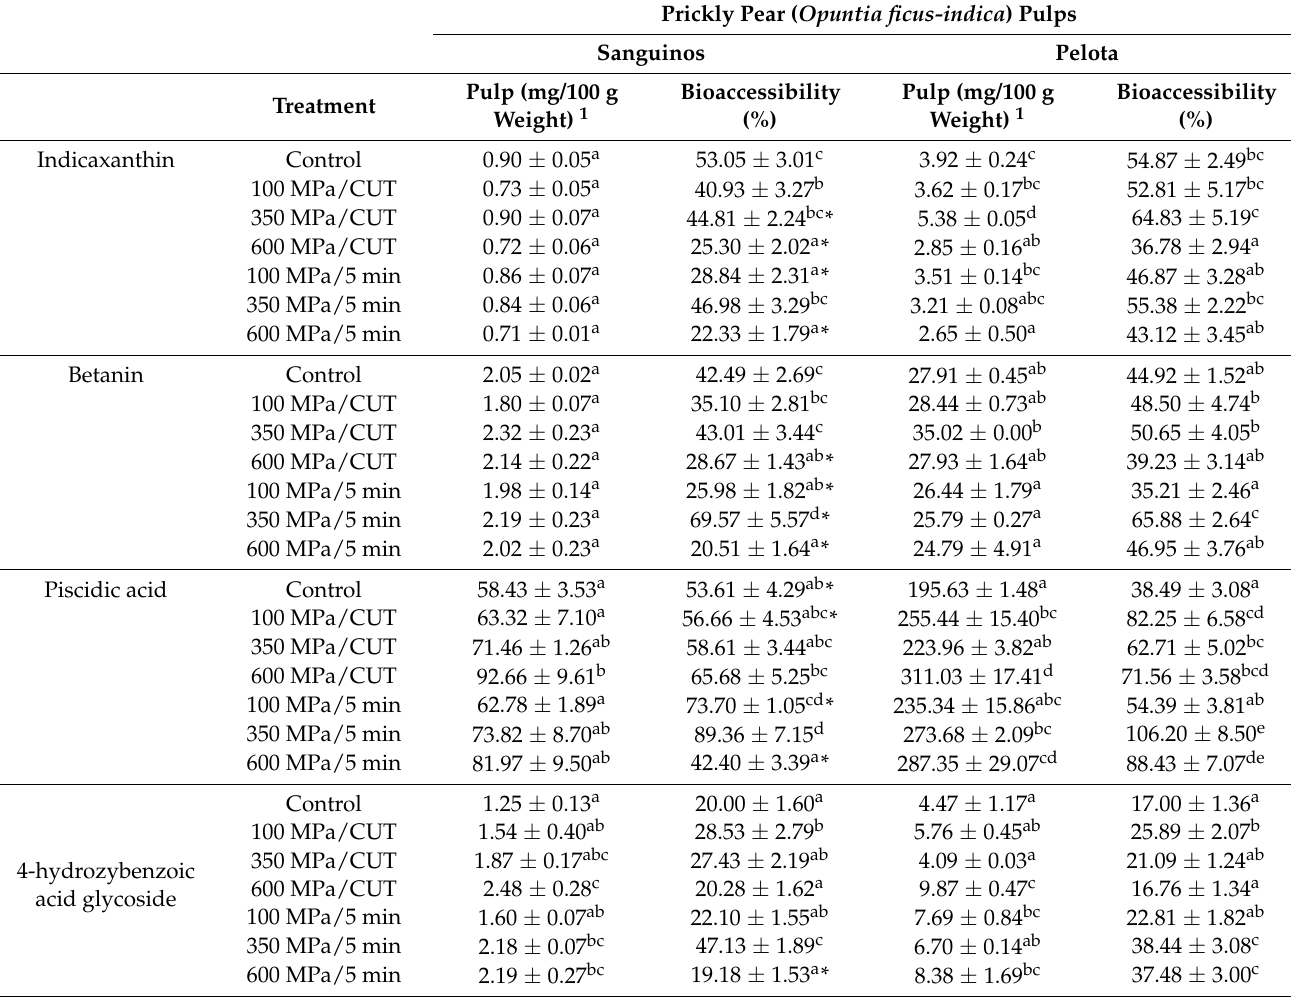
Table 2. Initial content (mg/100 g weight) and in vitro bioaccessibility of betalains and phenolic compounds in HHP-treated (100 MPa, 350 MPa, 600 MPa; CUT and 5 min) Sanguinos and Pelota prickly pear pulps and in untreated (control)